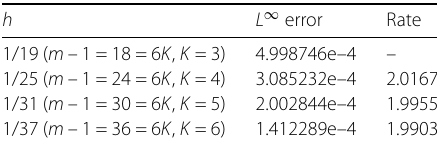
Table 1 Convergence rate of Algorithm 1 for h at t =